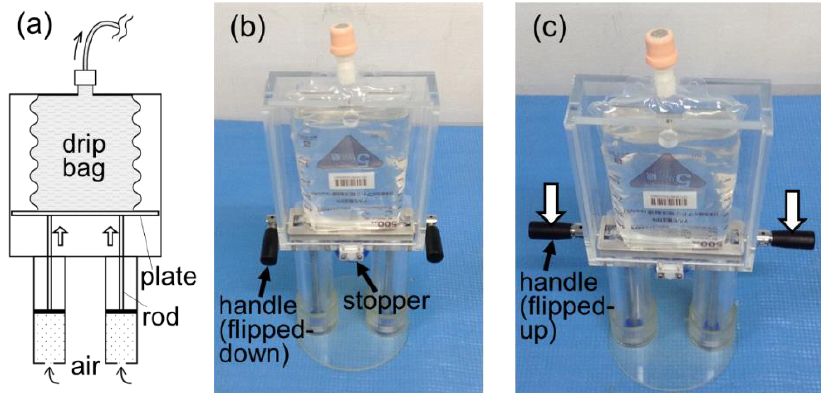
Figure 3. Prototype UP-PRESS. ( a ) A pressing plate, elevated by the vacuum piston cylinders through rods, exerts pressure on the drip bag. ( b ) The pressing plate is held at the standby position by a stopper. ( c ) Handles can be flipped up for the pressing plate to be reset (pushed down) to the standby